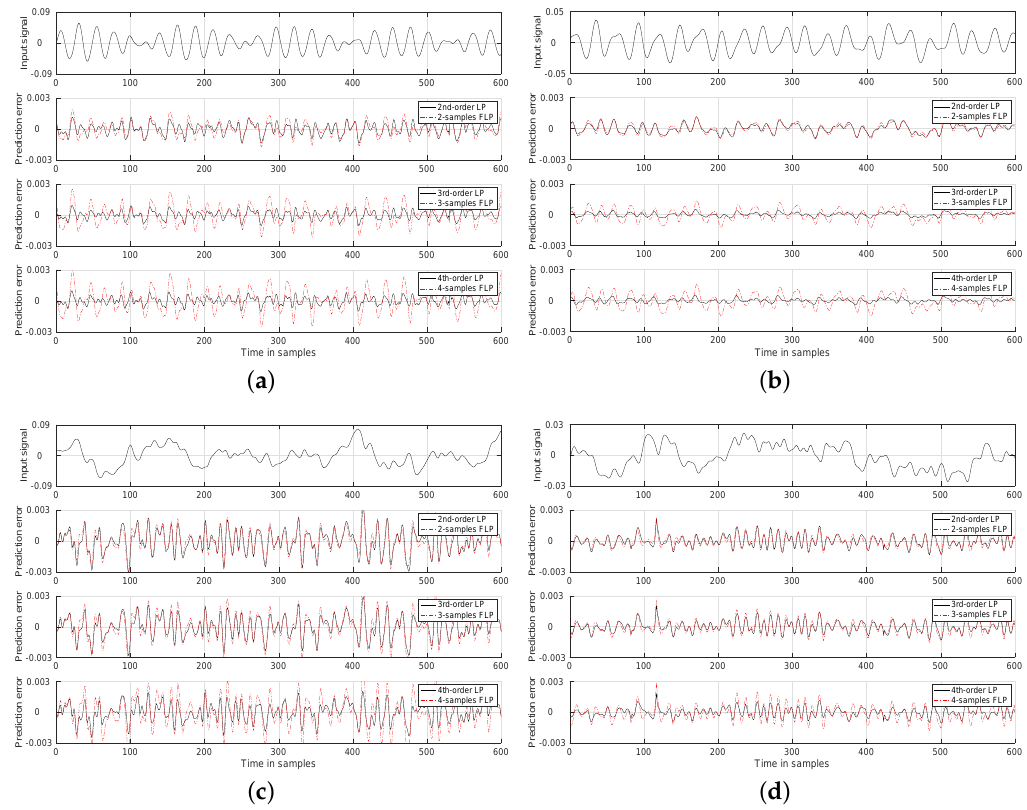
Figure 2. The prediction error results for the three-notes chords (MAPS–UCHO) for second-order, third-order and fourth-order LP and the FLP with the two-sample, three-sample, and four-sample memory: ( a ) studio recording; ( b ) jazz club recording; ( c ) church recording; and ( d ) concert hall